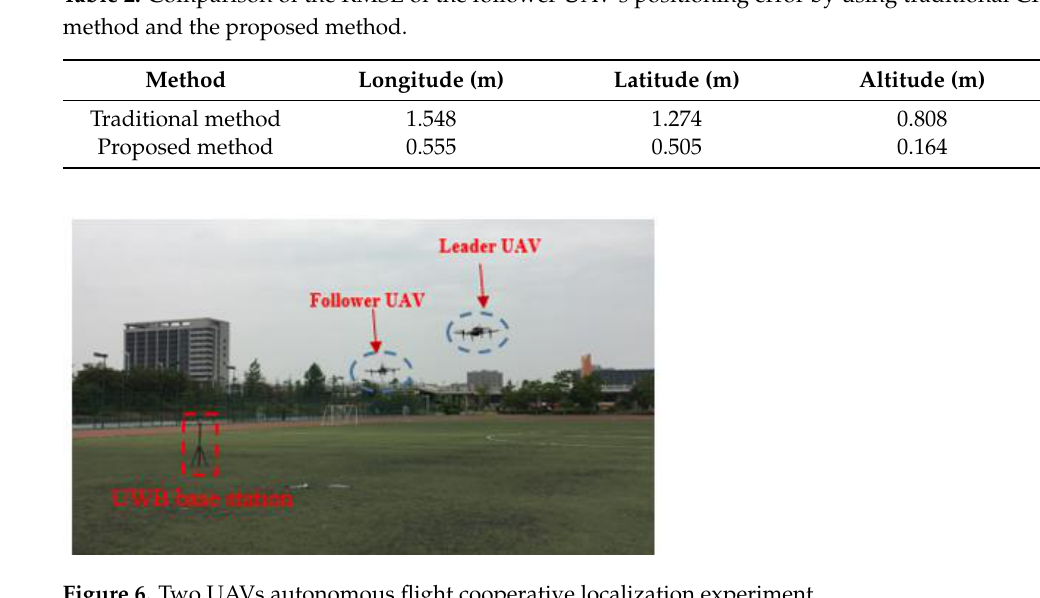
Figure 8. Follower UAV’s positioning error curve compar ison by using traditional multi - leader UAV CP method based on relative ranging and the proposed method. In order to more visually compare the follower UAV’s positioning performance by using the proposed method and the traditional multi-leader UAV CP method based on relative ranging, the root mean square error (RMSE) value of the follower UAV’s position- ing error is compared in Table 2. It can be seen from Table 2 that, under the condition that the follower UAV acquires relative distance information from the leader UAV at discon- tinuous times, the CP algorithm proposed in this paper has higher positioning accuracy than the traditional method. The follower UAV’s positioning accuracy is improved at least 50% compared to the traditional method. For the purpose of quantitatively comparing and analyzing the positioning performance of the proposed algorithm from various per- spectives, Figure 9 gives the mean and variance of the follower UAV’s positioning error by using the traditional CP method and the proposed method. We can conclude from the Figure 9 that when there are not enough known position leader UAVs in the UAV coop-